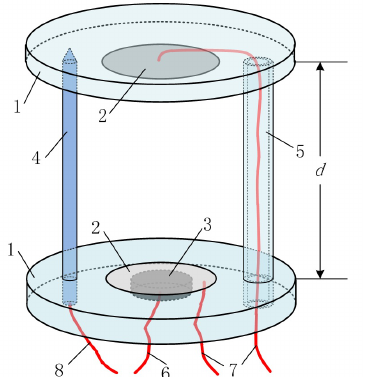
Figure 1. Sensor probe: ( 1 ) acrylic resin substrate; ( 2 ) stainless steel electrode; ( 3 ) piezoelectric transducer; ( 4 ) thermometer; ( 5 ) support beam; ( 6 ) ultrasonic transducer wire; ( 7 ) conductivity sensor wire; and ( 8 ) Thermometer